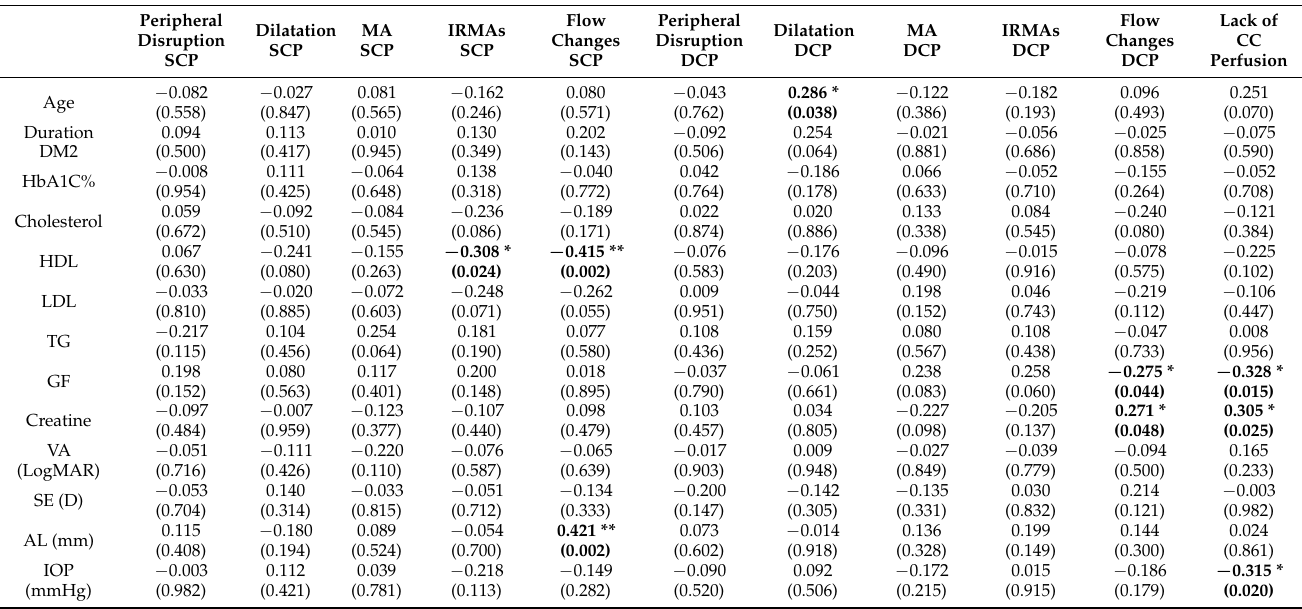
Table 4. Correlation coefficient and p -value (in brackets) of the anatomical alterations found in type 2 diabetes mellitus (DM2) with the different studied variables of visual function, disease duration and metabolic control. The values that reached statistical significance (* p < 0.05 and ** p < 0.01) are shown in bold. Abbreviations: SCP, superficial capillary plexus; DCP, deep capillary plexus; CC, choriocapillaris; MA, microaneurysms; IRMAs, intraretinal microvascular abnormalities; DM2, diabetes mellitus type 2; HbA1c (%), glycosylated haemoglobin; HDL, high-density lipoprotein; LDL, low-density lipoprotein; TG, triglycerides; GF, glomerular filtration; VA, visual acuity; LogMAR, logarithm of the minimum resolution angle; SE, spherical equivalent; D, diopters; AL, axial length; IOP, intraocular pressure.